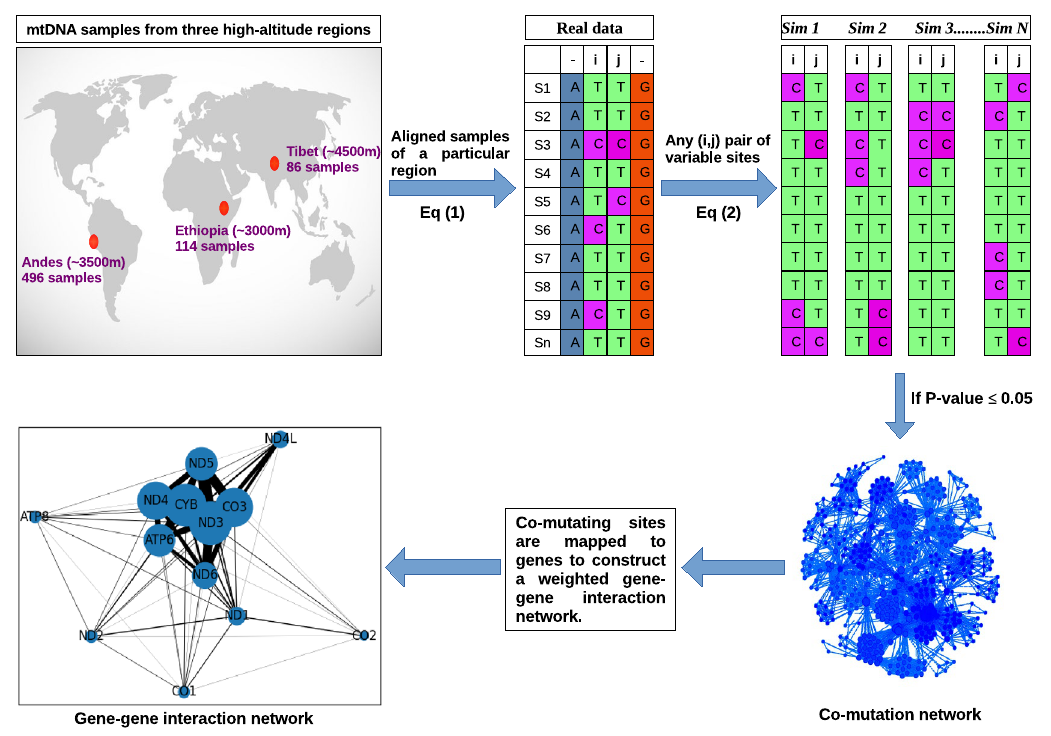
Figure 1. Construction of Co-mutation network and Gene–Gene Interaction (GGI) network for each high- altitude region as explained in “Methods”